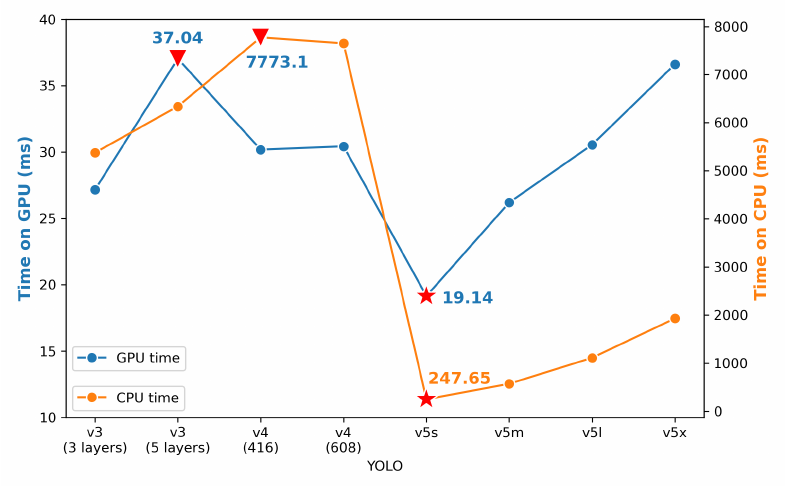
Figure 13. Average time for processing one image in each